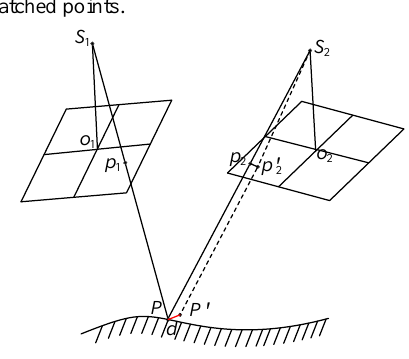
Figure 8. Using forward intersection residuals to eliminate wrong matched points